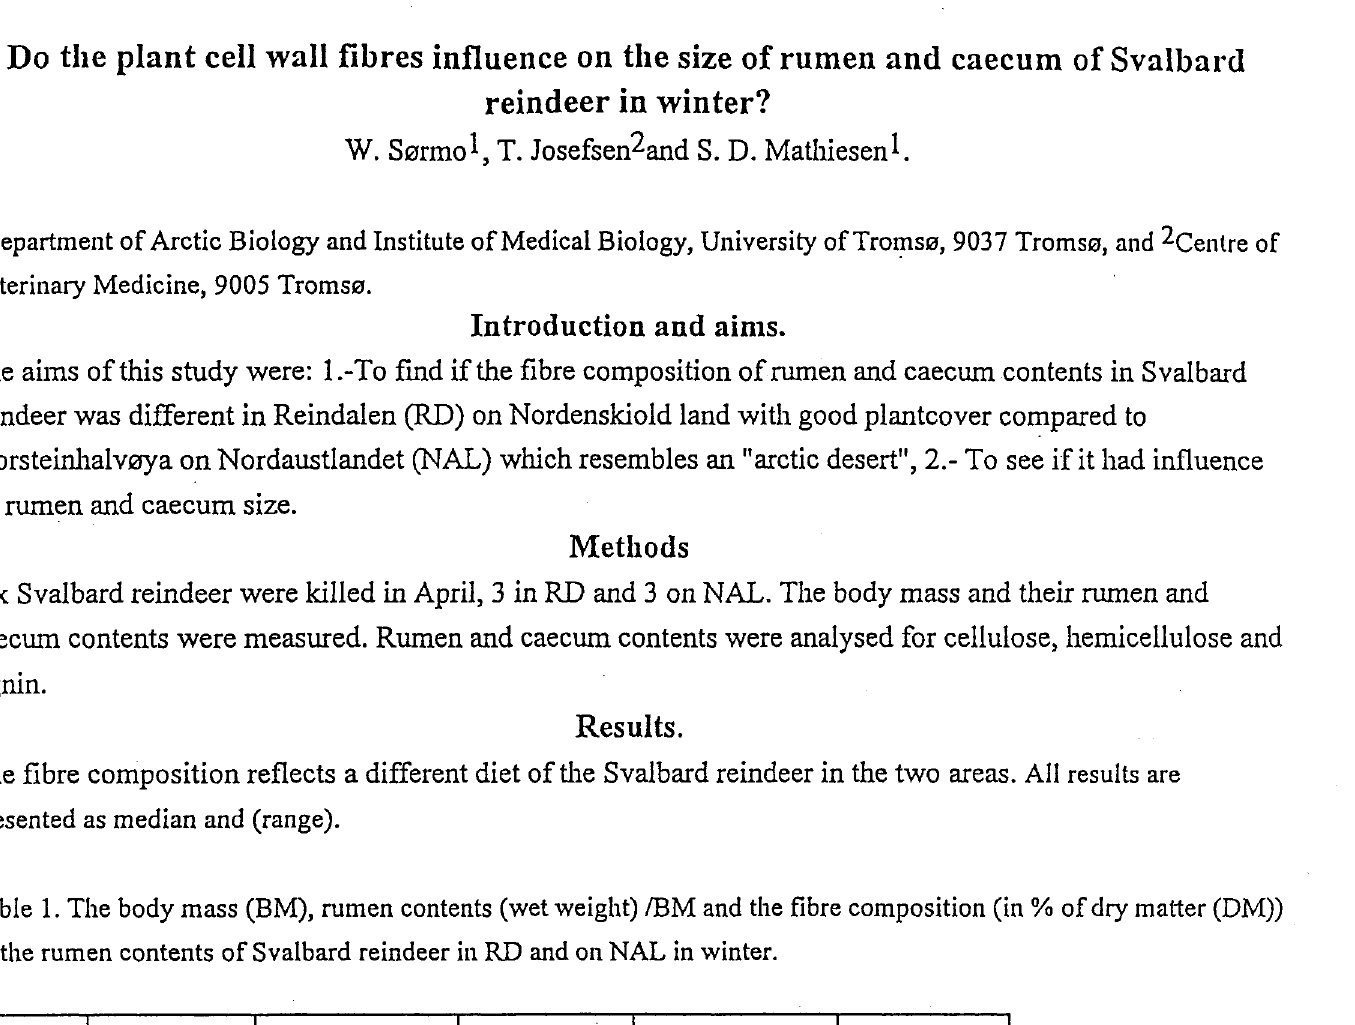
Table 1. The body mass (BM), rumen contents (wet weight) /BM and the fibre composition (in % of dry matter (DM)) of the rumen contents of Svalbard reindeer in RD and on NAL in winter.